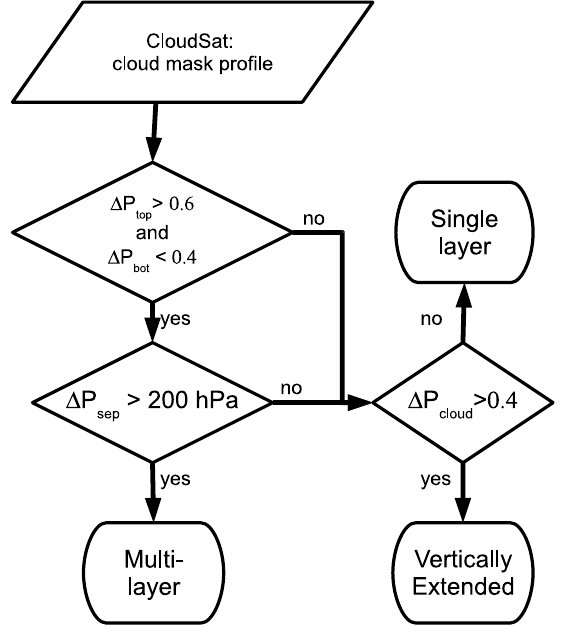
Fig. 5. Flow chart describing CloudSat multi-layer/extended cloud detection scheme.